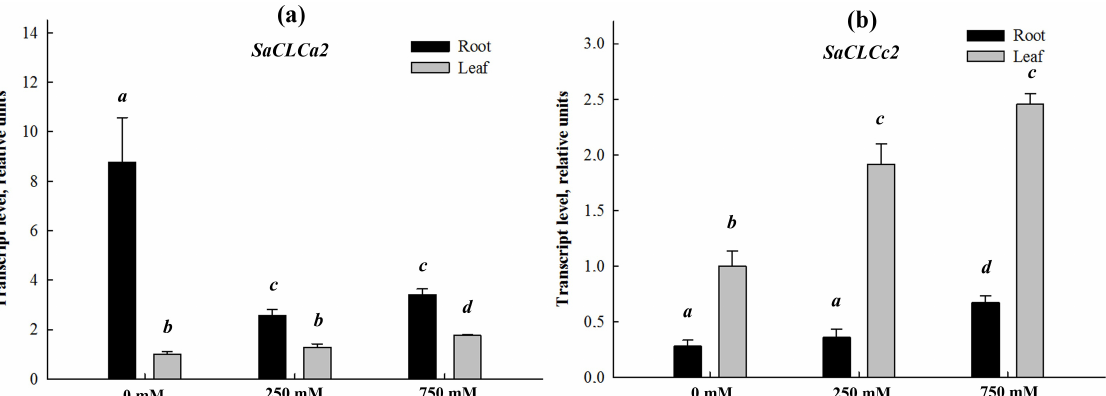
Figure 4. Relative abundance of SaCLCa2 ( a ) and SaCLCc2 ( b ) transcripts in roots (dark bars) and leaves (light bars) of Suaeda altissima plants grown at various NaCl concentrations in the plant growth medium. Data shown are means ± SE from three independent experiments. Each of them was performed in three analytical replicates. Bars with different letters are significantly different at p < 0.05.